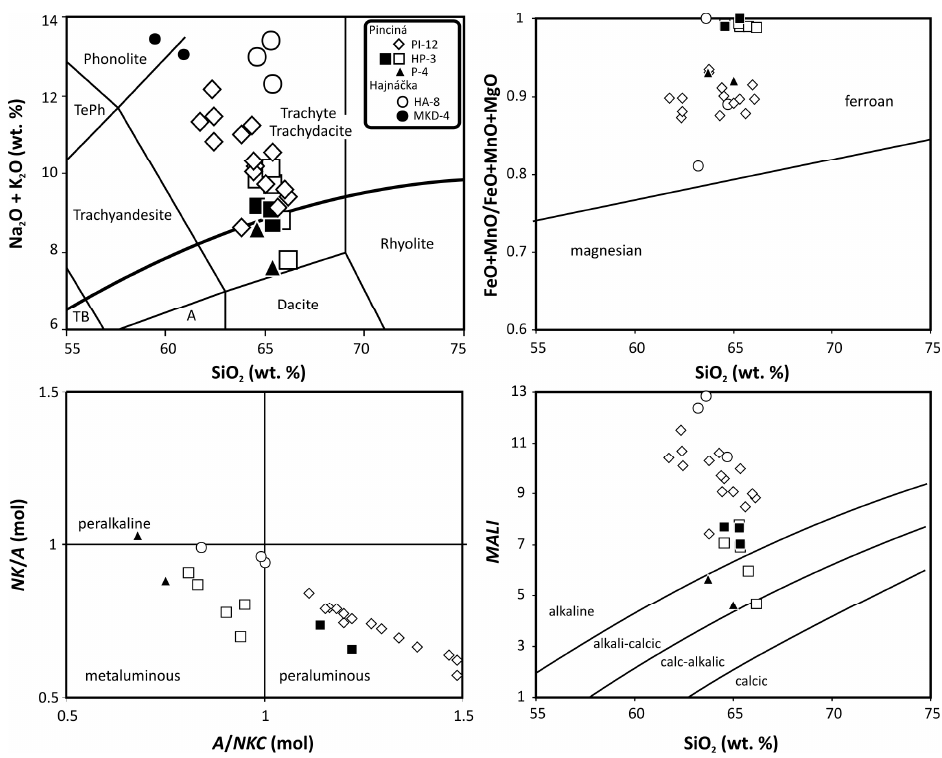
Figure 12. Classification diagrams of magmatic rocks based on major elements [36–38], with projec- tion points of silicate glass from Pinciná (PI, HP, P) and Hajná č ka (HA, MKD) (Table S5). A/NKC = Al 2 O 3 /(CaO + Na 2 O + K 2 O–1.67P 2 O 5 ), NK/A = (Na 2 O + K 2 O)/Al 2 O 3 , MALI = Na 2 O + K 2 O–CaO. Black and open symbols refer to silicate glass inclusions in zircons and interstitial glass, respectively. Ab-